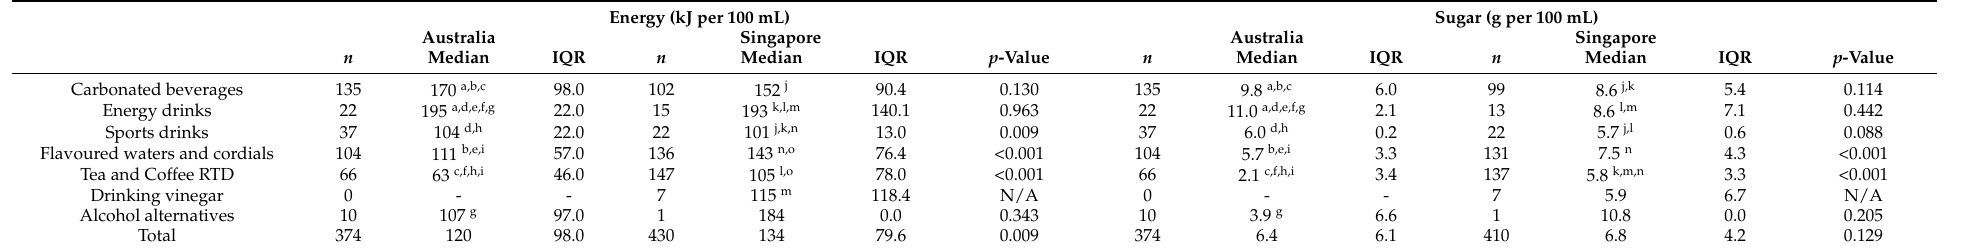
Table 3. Nutritional compositions (/100 mL) of calorically sweetened beverage products collected within each subcategory in Australia (2019) and Singapore (2020), showing the number of beverages (n) and the median and IQR values for energy and sugar.